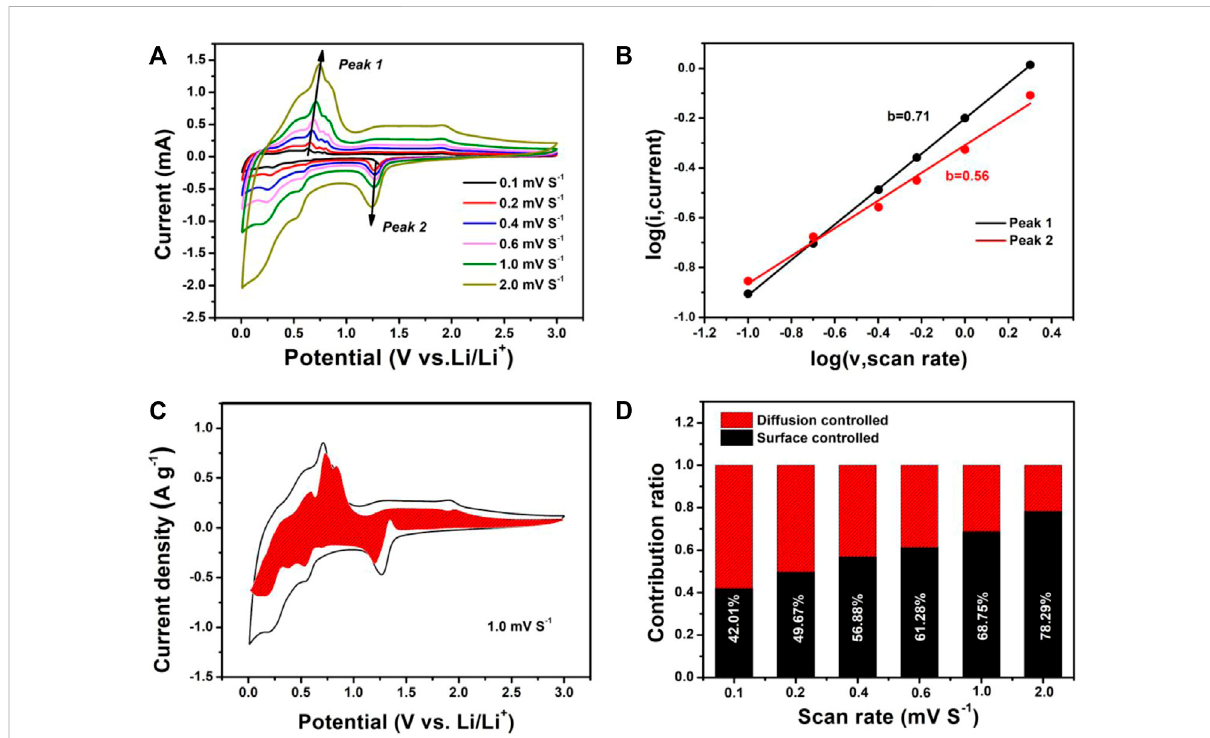
FIGURE 5 Electrochemical kinetics of the SnS@C/G composite for lithium storage: (A) CV curves at various scan rates, (B) determination of the b value usingEq.1, (C) normalizedcontribution ratioofthecapacitiveanddiffusioncurrentatascanrateof1.0 mV s − 1 , (D) contributionofthecapacitive and diffusion-controlled charge transport process at different scan